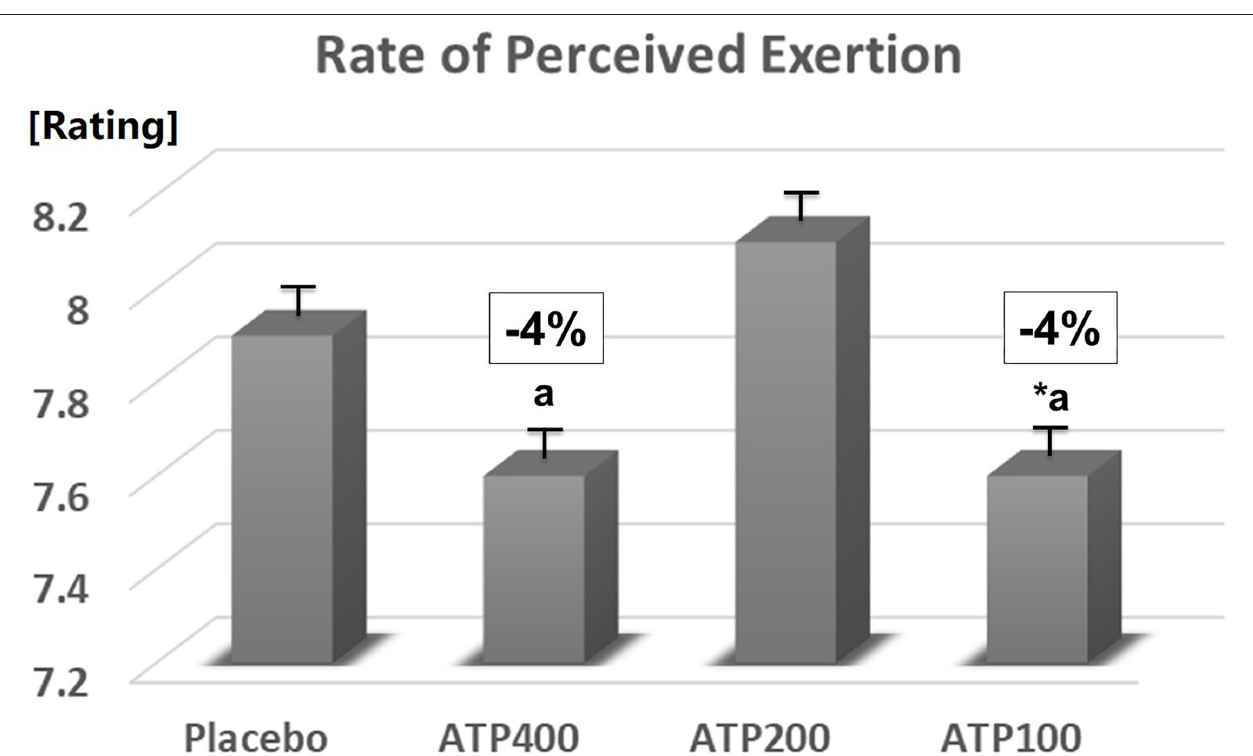
Frontiers in Sports and Active Living |